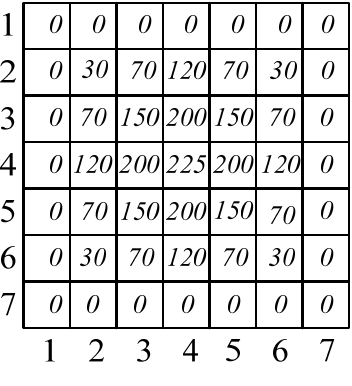
Figure 7. The simulated spot gray